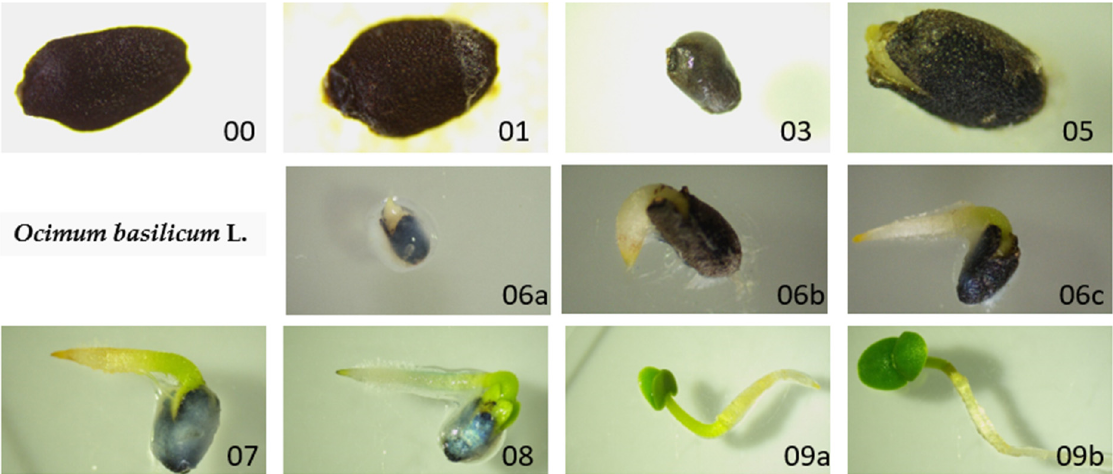
Figure 1. Basil germination stage completed according to BBCH scale for growth and develop- ment (00—dry/inactive seed, 01—beginning of seed imbibition, 03—seed imbibition complete, 05—radicle emerged from seed, 06a—radicle elongation, no root hair, 06b—radicle elongation with root hair present, 06c—radicle elongation further the root hair zone, 07—hypocotyl with cotyledons, 08—hypocotyl with cotyledons outside seed coat, 09a—emergence, folded cotyledons, 09b—emergence, unfolded